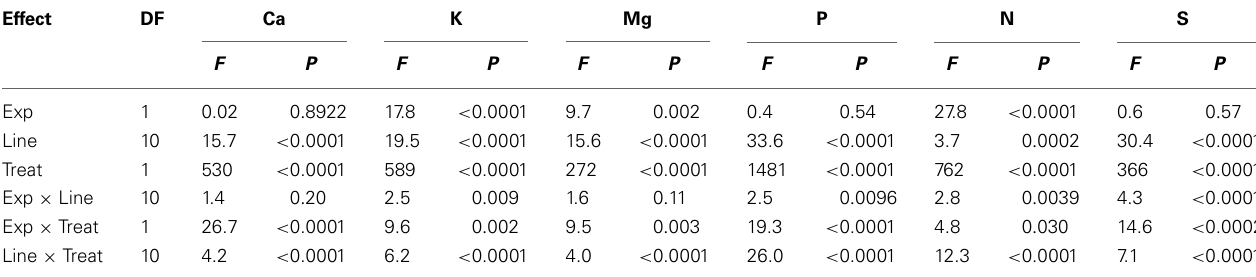
Table 3 | Analysis of variance ( F and P values) of the effects of water treatment (Treat) on macronutrients in the fully expanded leaves at boll